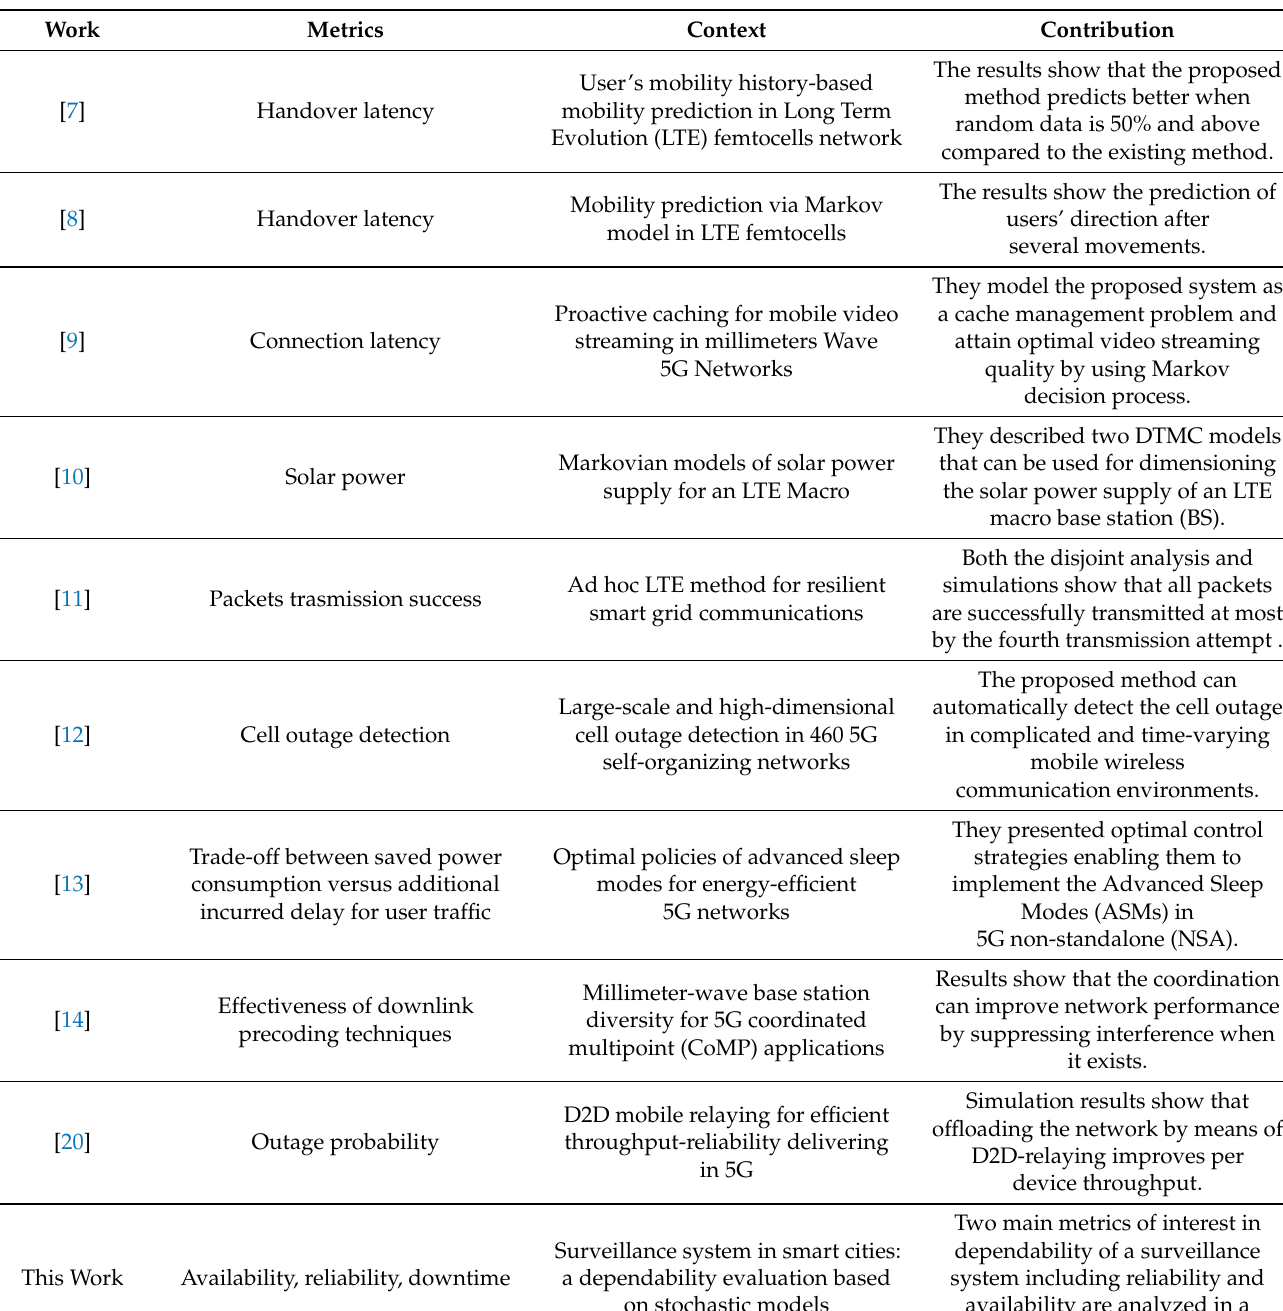
Table 1. Comparison with related